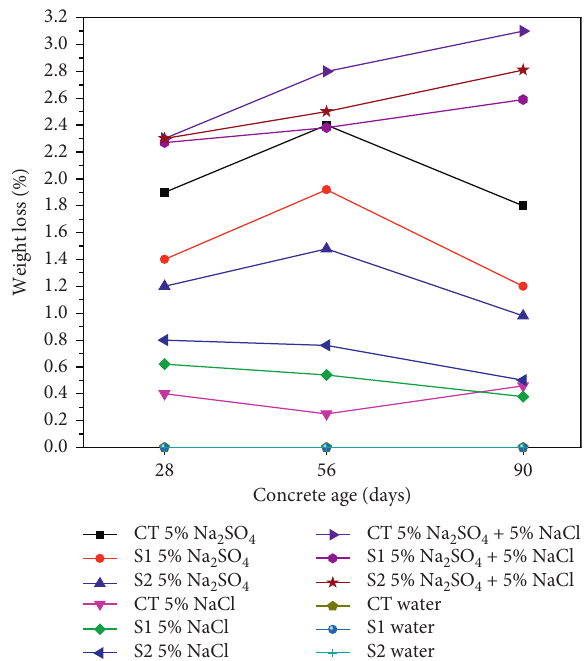
— — — — Figure 3: Weight loss of CT, S1, and S2 immersed in sulphate, chloride, and combined sulphate and chloride